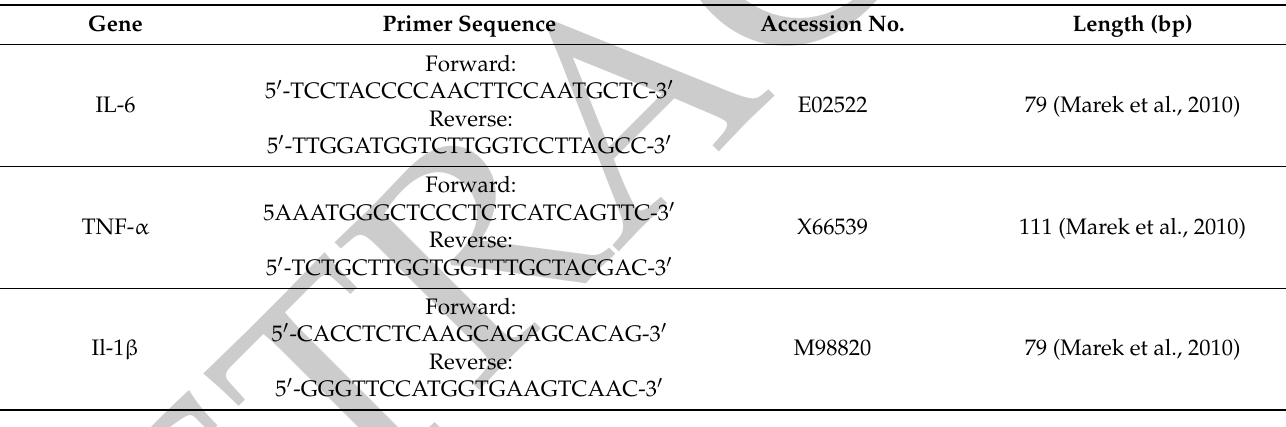
(Table 5). The relative mRNA expression of IL-1 β , IL-6, and TNF- α was elevated in STZ- treated rats as compared to those of the control group. In the DC group treated with stem declined as compared to the STZ group (Table 6). Table 5. Primer sequences for PCR amplification.